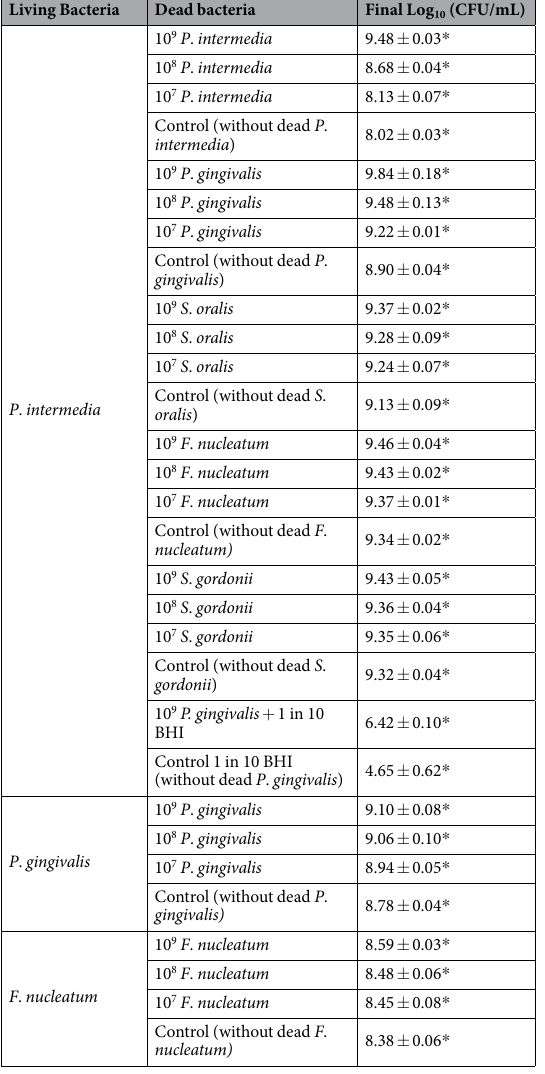
Table 1. Effect of dead bacteria on bacterial growth of periodontal pathogens. Data represent the final cell concentration of living periodontal pathogens (Log 10 CFU/mL)after 24 anaerobic incubation starting from 7.7 Log 10 CFU/mL and in presence of different concentrations of dead bacteria (mean ± standard deviation, n = 3). Control contains only living bacteria without addition of dead bacteria. * Statistically significant difference of periodontal pathogens concentration in presence of dead bacteria respect to the control (p <